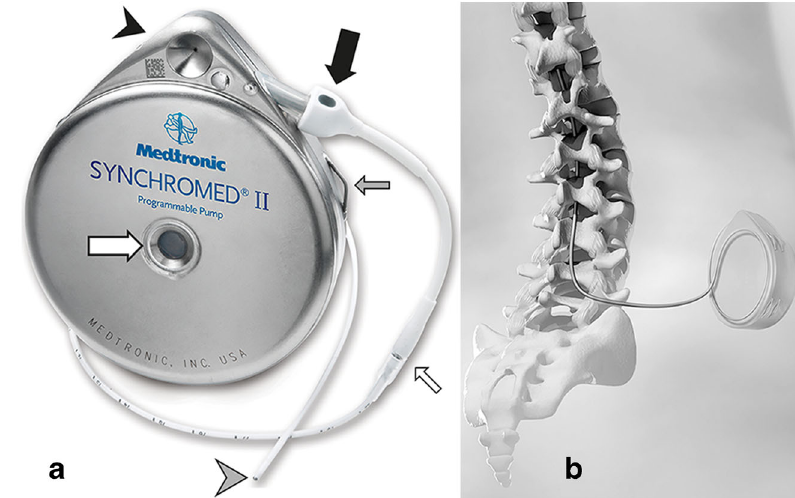
Fig. 1 Implanted, programmable pump system. External view ( a ) and drawing of implanted pump and intrathecal catheter 8731SC ( b ). Pump with the catheter access port ( black arrowhead ), pump catheter connection ( thick black arrow ), refill membrane ( thick white arrow ) and suture loops for fixation ( thin grey arrow ), catheter-catheter segment connection ( thin white arrow ) and